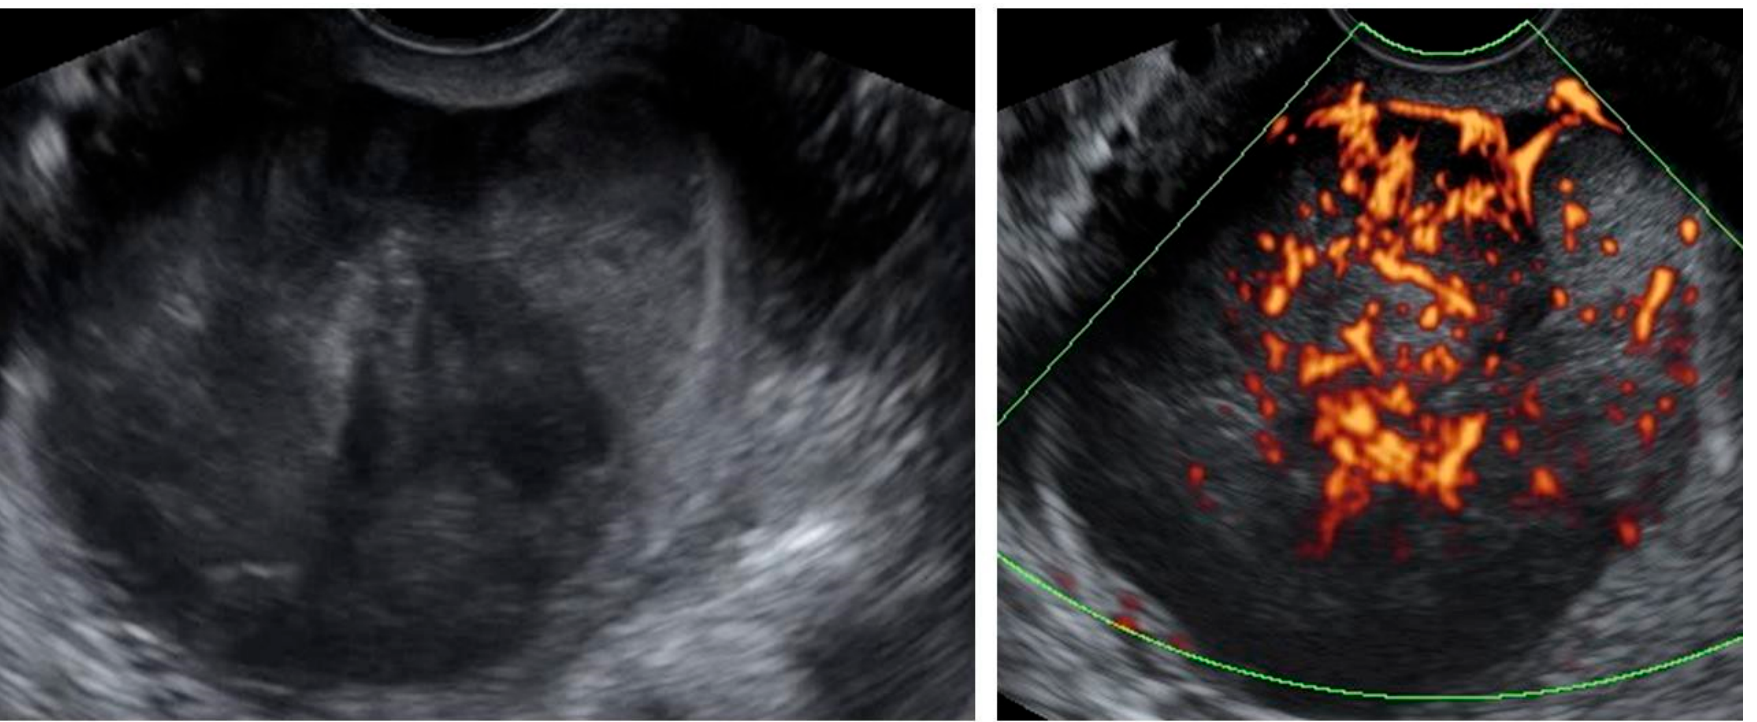
Figure A6. Transvaginal ultrasonogram of the uterine lesion (atypical) in the myometrium, B mode and Doppler. Histology: leiomyoma, epithelioid variant .